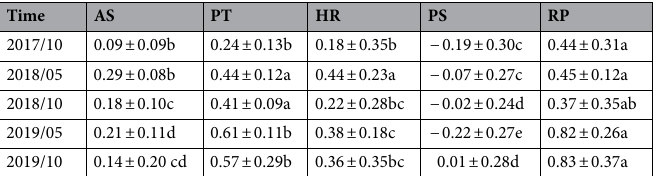
Table 5. The CSWSD of different types (0–200 cm). Different letters on the same line indicate significant differences ( p < 0.05).